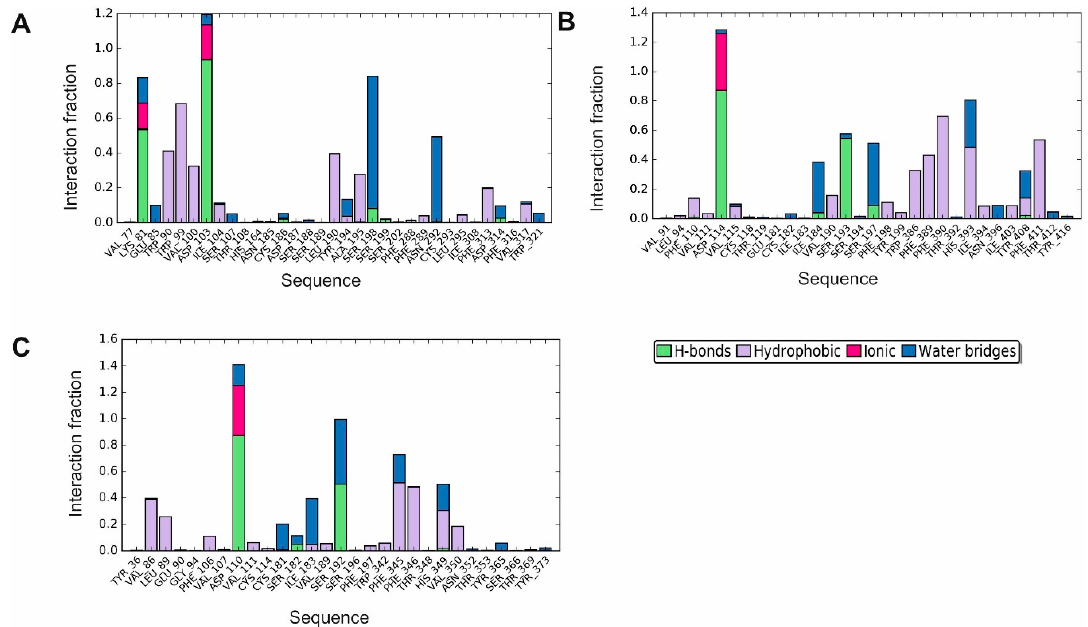
Figure 6. Molecular interactions of D2AAK4 with human dopamine D 1 ( A ), D 2 ( B ) and D 3 ( C ) receptor during 200 ns molecular dynamics simulations are shown as histograms of interactions. The stacked bar charts are normalized over the course of the trajectory: for example, a value of 0.7 suggests that for 70% of the simulation time the specific interaction is maintained. Values over 1.0 are possible as some protein residue may make multiple contacts of the same subtype with the ligand.